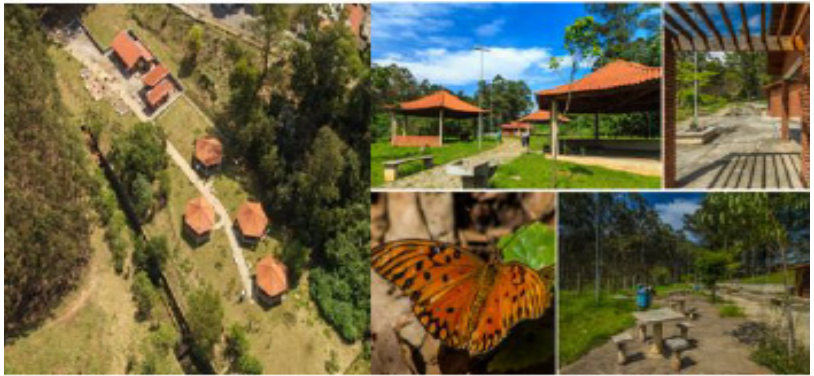
Figure 1. Municipal Park Jardim Primavera [18].